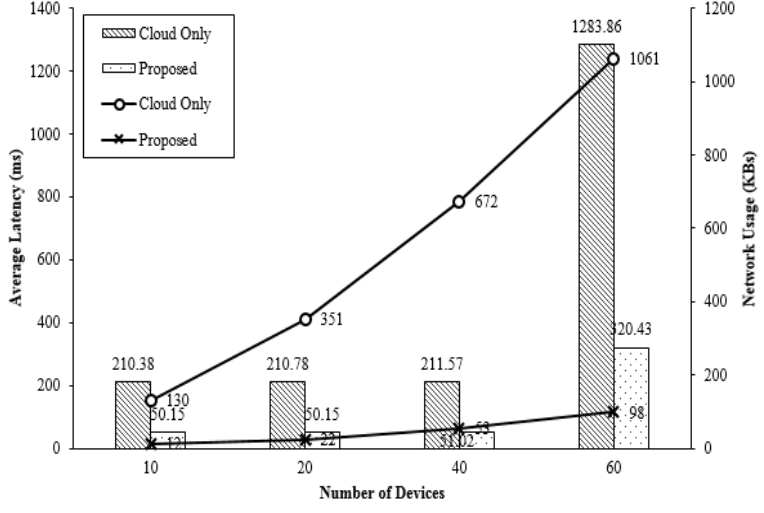
Figure 13. Average Latency and Network Usage Comparison.